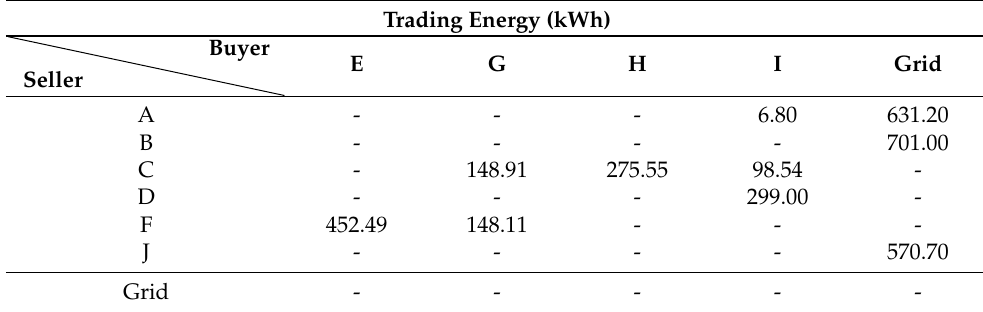
Table 11. Results of transaction: trading energy part after re-profiling.